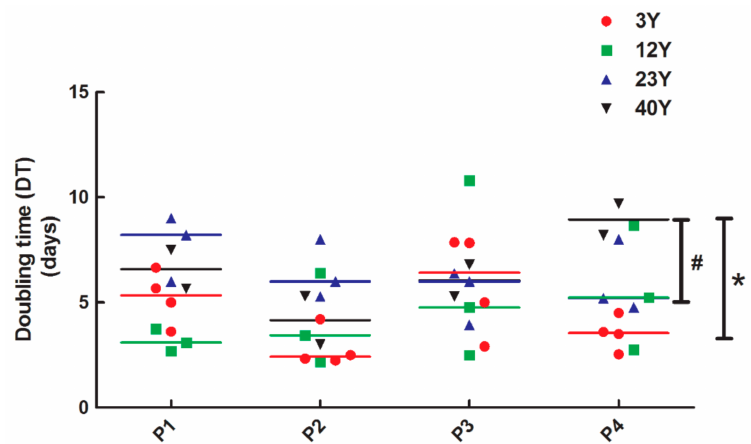
Figure 5. Doubling time for SfMSCs isolated from equine donors of di ff erent ages and cultured in vitro from passage 0 (P0) to passage 4 (P4). Values corresponding to each donor and the mean value (colored line) corresponding to each age-related group are reported. * represents a significant di ff erence between 3Y and 40Y groups; p < 0.05. # represents a significant di ff erence between 12Y and 40Y groups at P4; p <